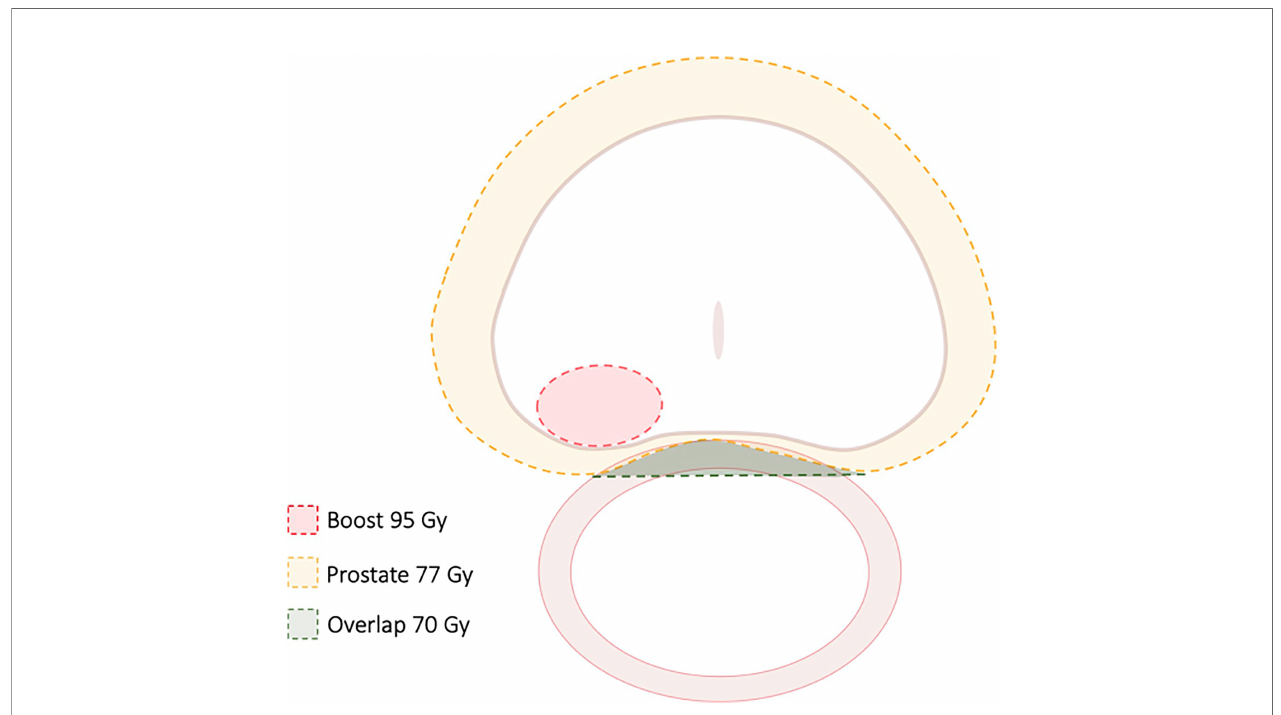
FIGURE 2 | Treatment Guidelines for FLAME study. In this randomized study of focal dose escalation, in the experimental arm patients received 77 Gy to the PTV (70 Gy where there was overlap with the rectum) and 95 Gy to the MRI-de fi ned GTV in 35 fractions using a simultaneous integrated